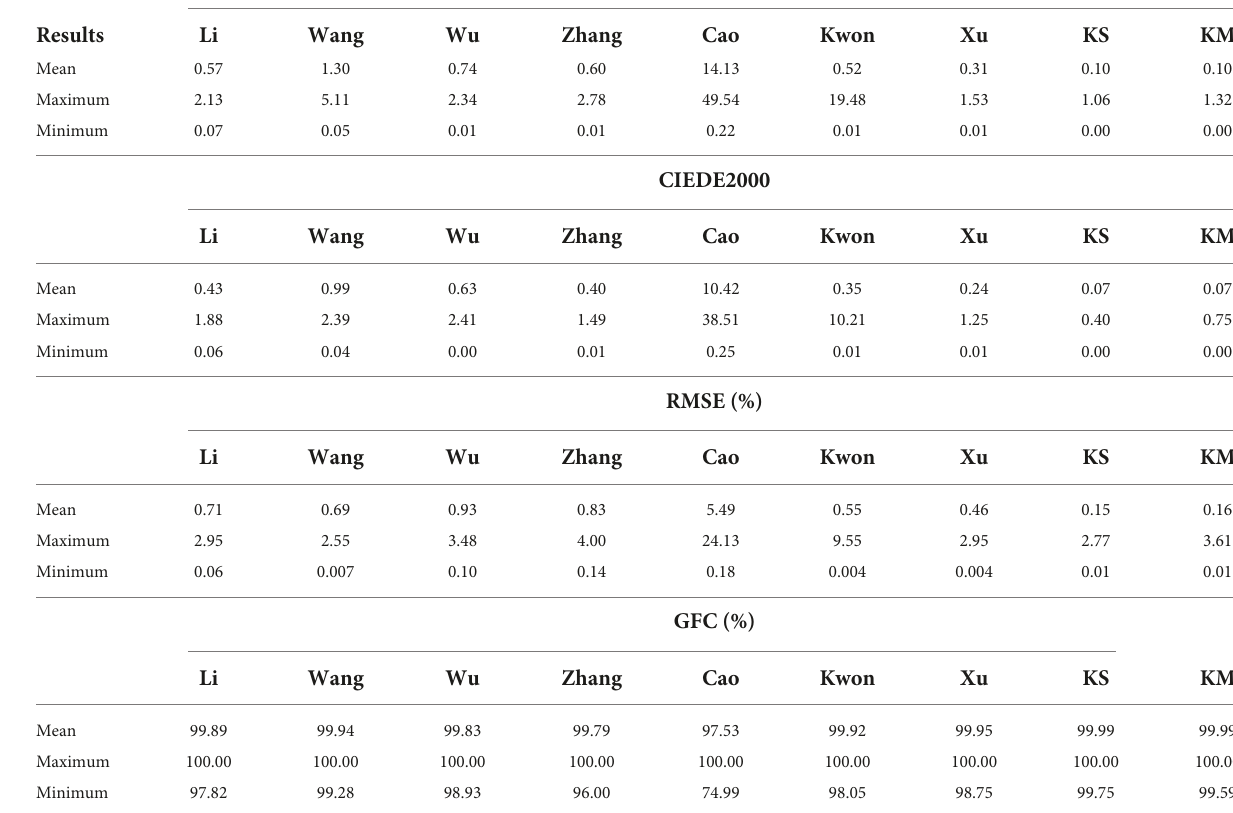
TABLE 1 Simulated spectral recovery results of the proposed and other existing methods.